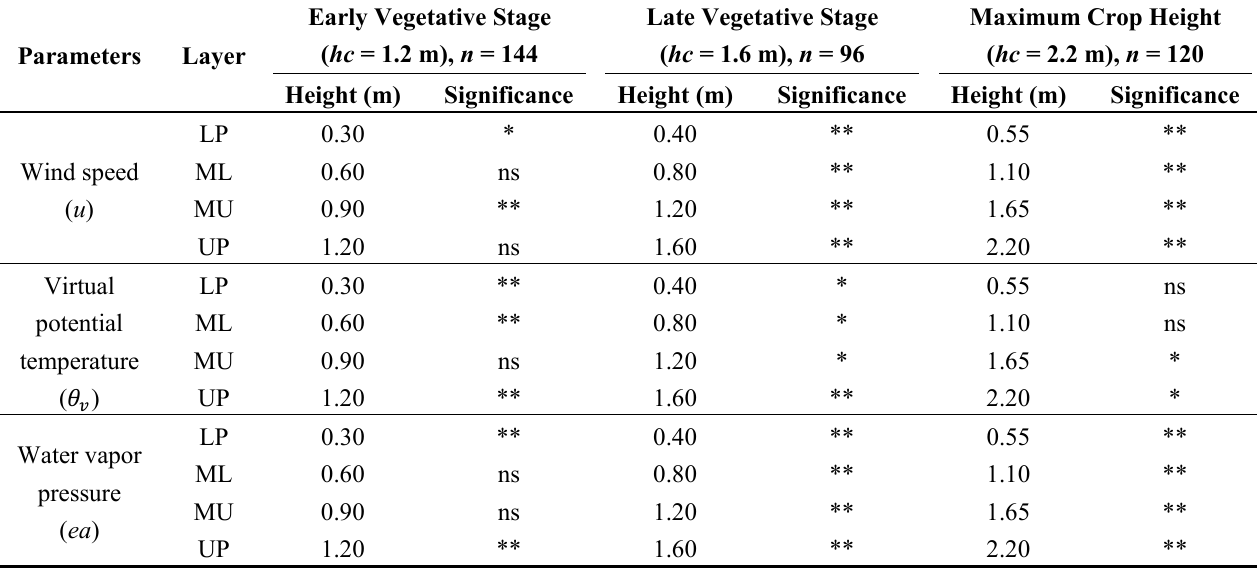
Table 2. Statistical comparison between wide and narrow runoff strip length (RSL) treatments for hourly wind speed ( u ), virtual potential temperature ( (cid:2016) vapor pressure ( ea